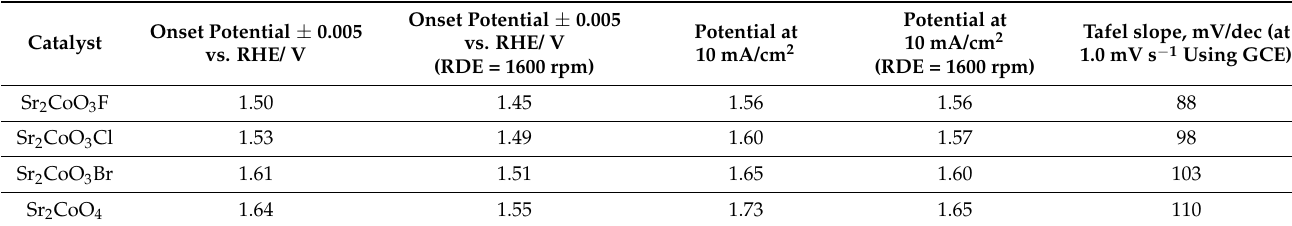
Table 3. The oxygen evolution onset potential and overpotential at a current density of 10 mA/cm 2 ( η 10% ) and Tafel slope of the strontium cobalt oxyhalides catalysts.